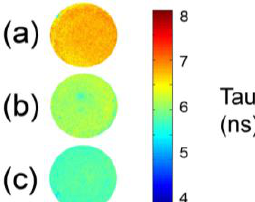
Figure 3. Fluorescence lifetime of ( a ) egg white; ( b ) collagen-based glue; ( c ) egg